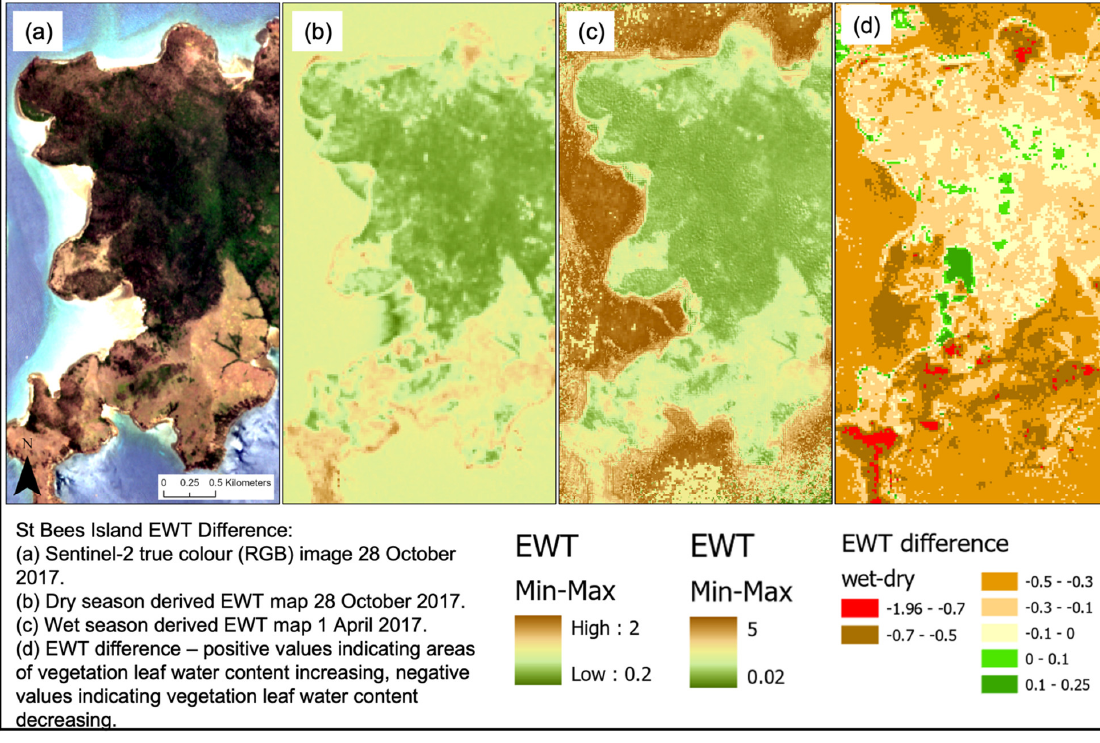
Figure A12. St Bees Island EWT Difference.